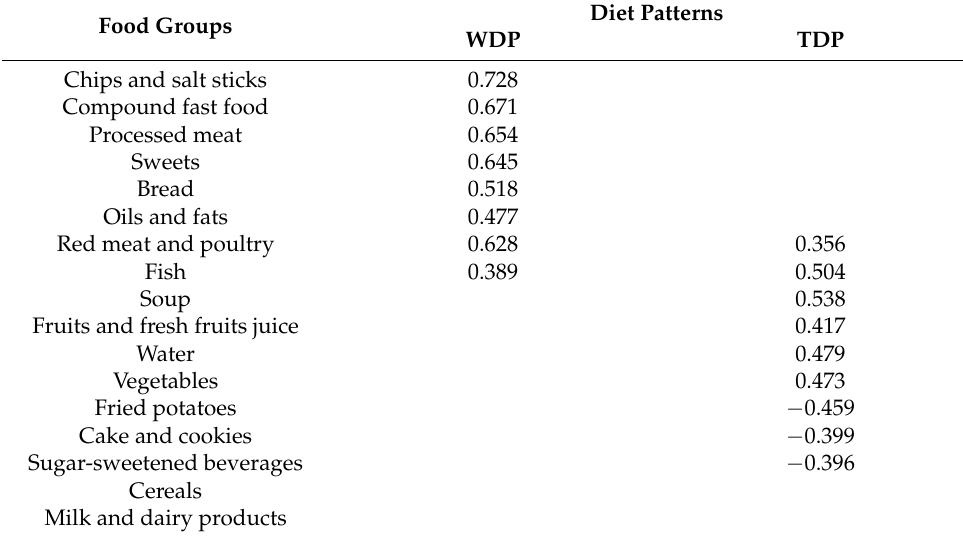
Table 3. EFA results on the dietary